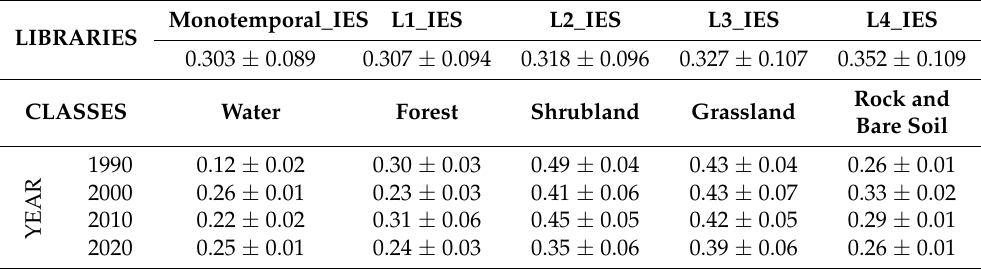
Table 4. RMSE average values and standard deviation (SD) obtained of the linear regressions for the different optimized libraries and for each type of habitat and year analyzed.